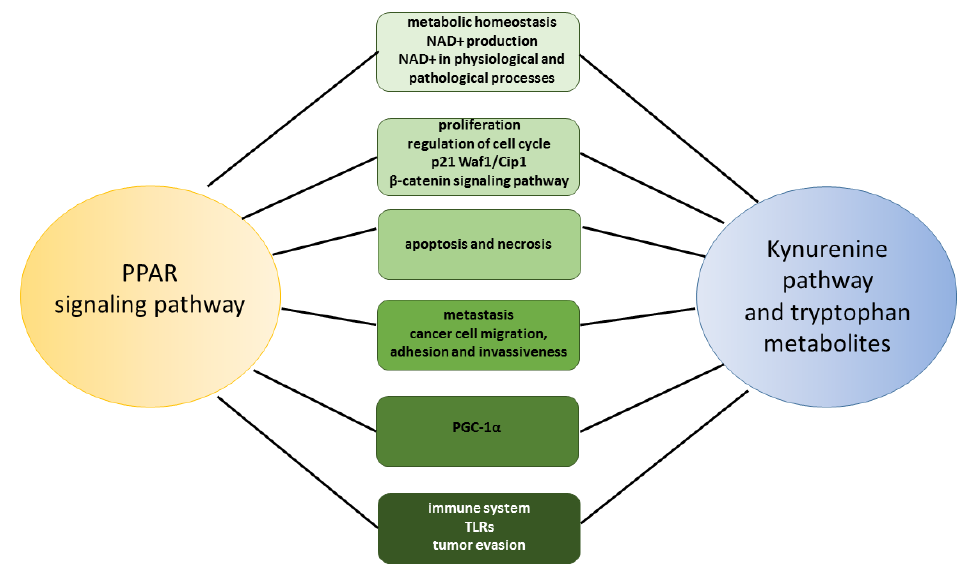
Figure 5. Scheme of potential interactions between the PPAR signaling pathway and the kynurenine pathway.